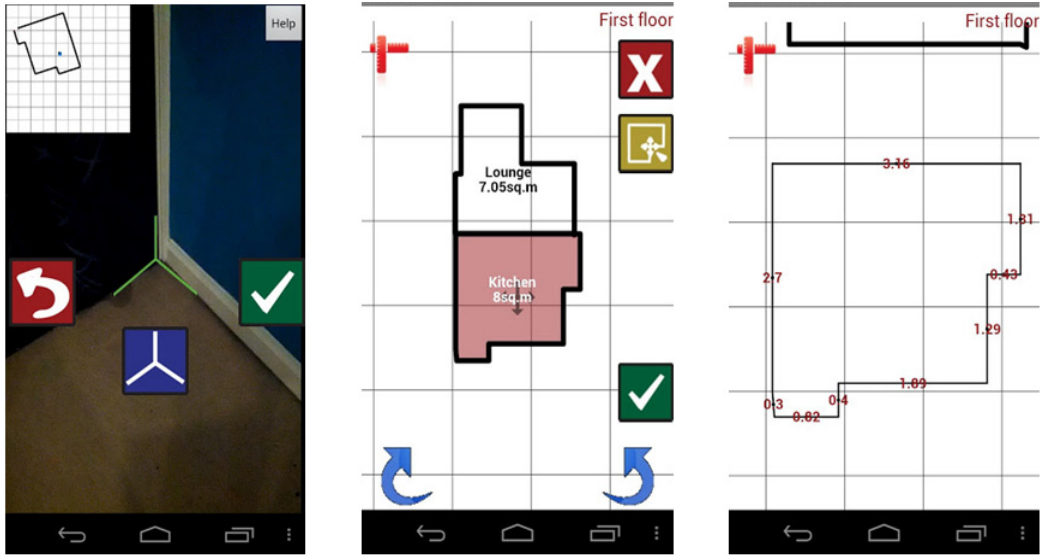
Figure 2. Mobile application screens. Room capture ( left ), room layout ( centre ), room measurement detail ( right